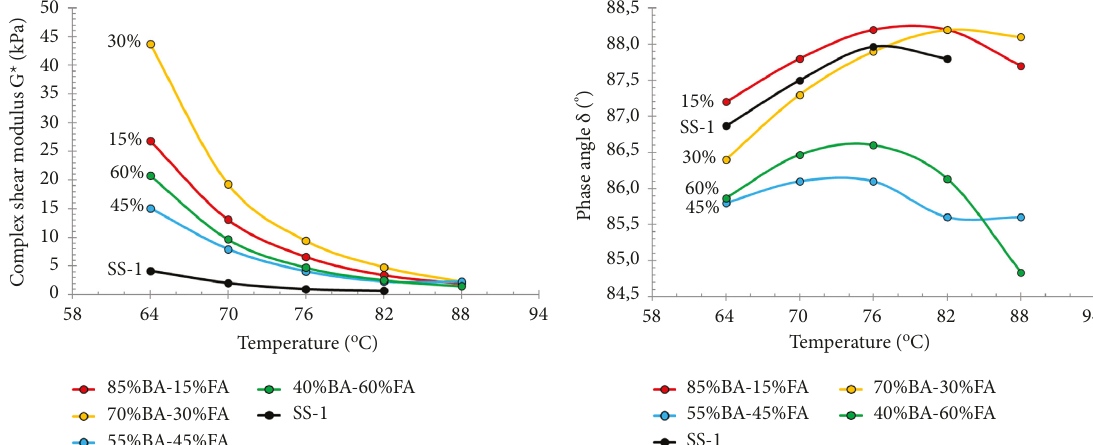
Figure 7: DSR results, shear modulus, and phase angle @ 1.59Hz, of the residual bitumen from the emulsion (SS-1) and fly ash mixes with mixing method